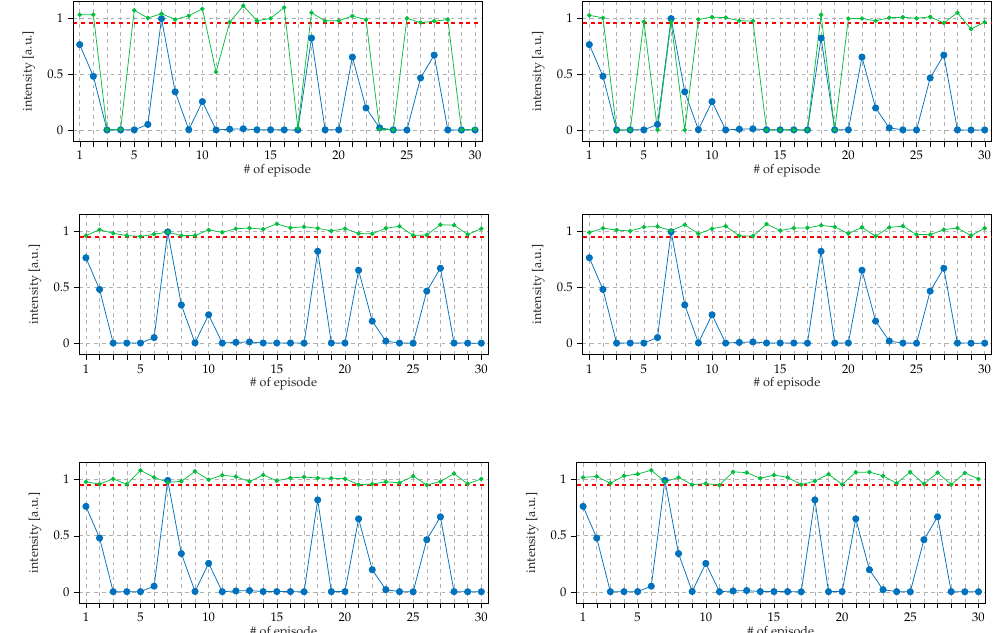
Figure 3. Normalized detected intensity at the end of each episode (green) for each online iLQR run, starting from an initial detected intensity (blue) and given a target intensity (red). The subfigures are run ordered, i.e., Section 3.2 reports the results of the first performed run, while Section 3.2 reports the results of the last performed run. Starting from the third run, the proposed approach results in achievement of the goal for each episode.